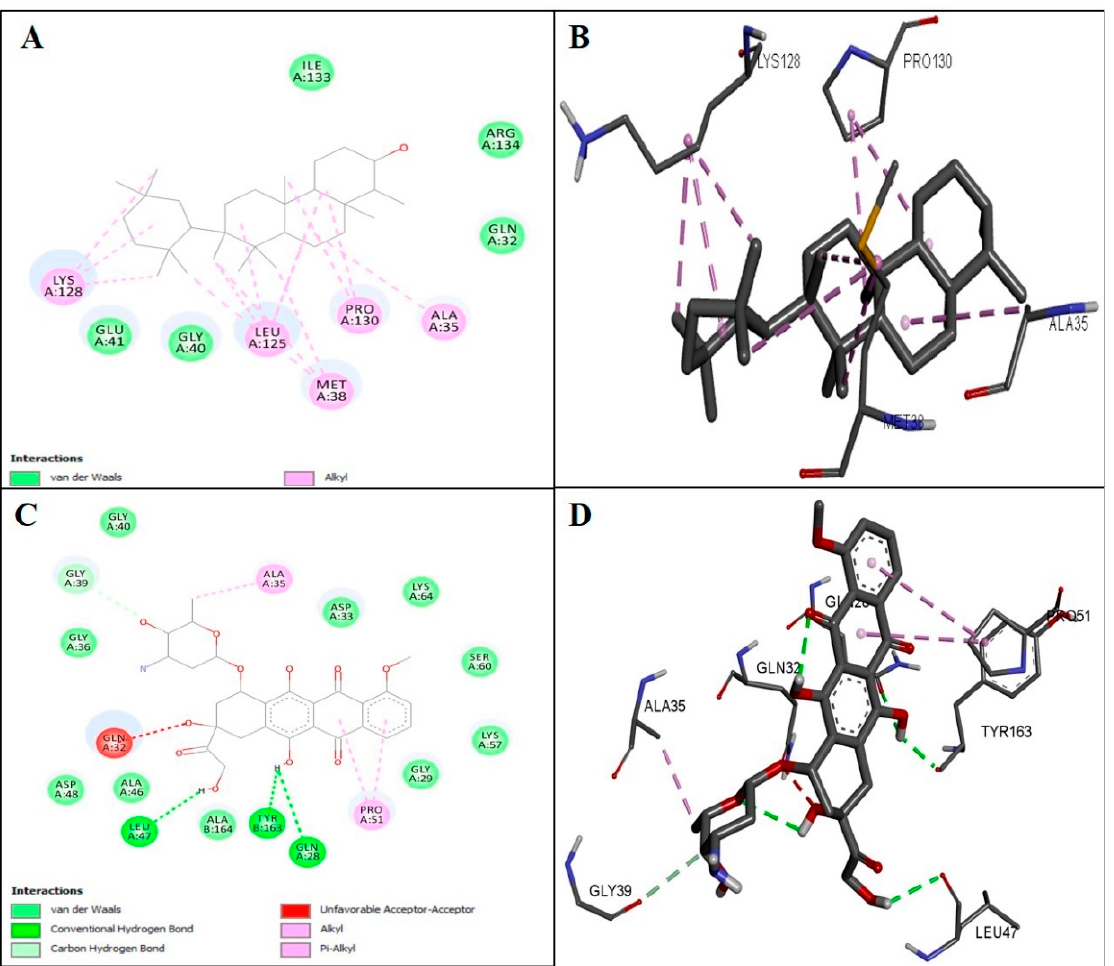
Figure 2. Representation of docked ligands to BAX (PDB-ID 2K7W). ( A ) 2D ( B ) 3D images of EFD presenting binding with BAX. ( C ) 2D ( D ) 3D images of Doxorubicin presenting binding with BAX. Van der Waals, H-bonding, unfavorable acceptor-acceptor, Pi-anion, Pi-sigma, alkyl and Pi-alkyl interactions are involved in ligands binding in protein